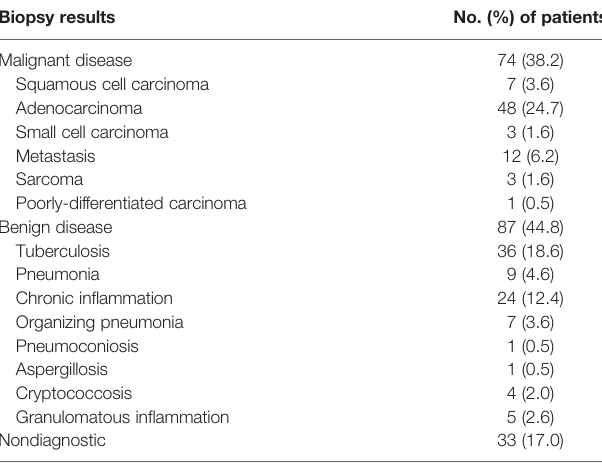
TABLE 2 | Pathological results of ultrasound-guided biopsy for 194 PPLs. Biopsy results